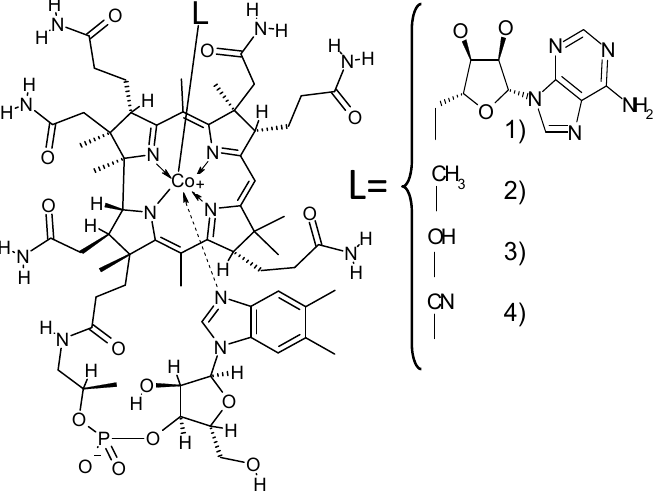
Figure 1. Structural formula of Vitamin B compounds. The partial structures of the Vitamin B of the molecule that differ from Vitamin B ( 2 ) methylcobalamin; ( 3 ) hydroxocobalamin; and ( 4 ) cyanocobalamin or Vitamin B